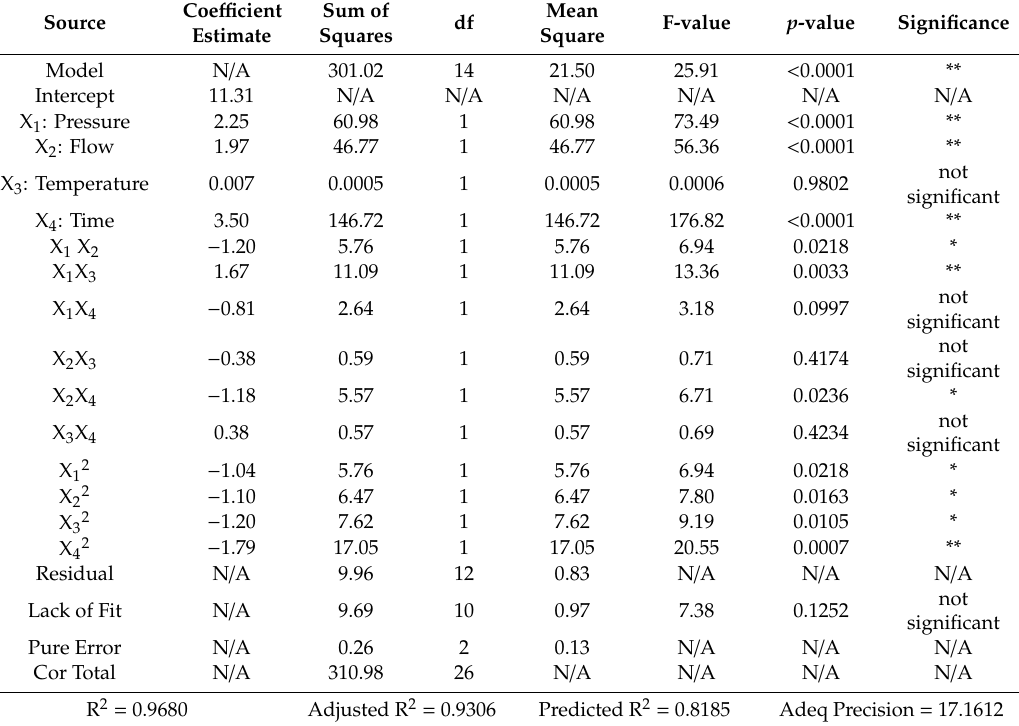
Table 2. The results of analysis of variance (ANOVA) of the response surface quadratic